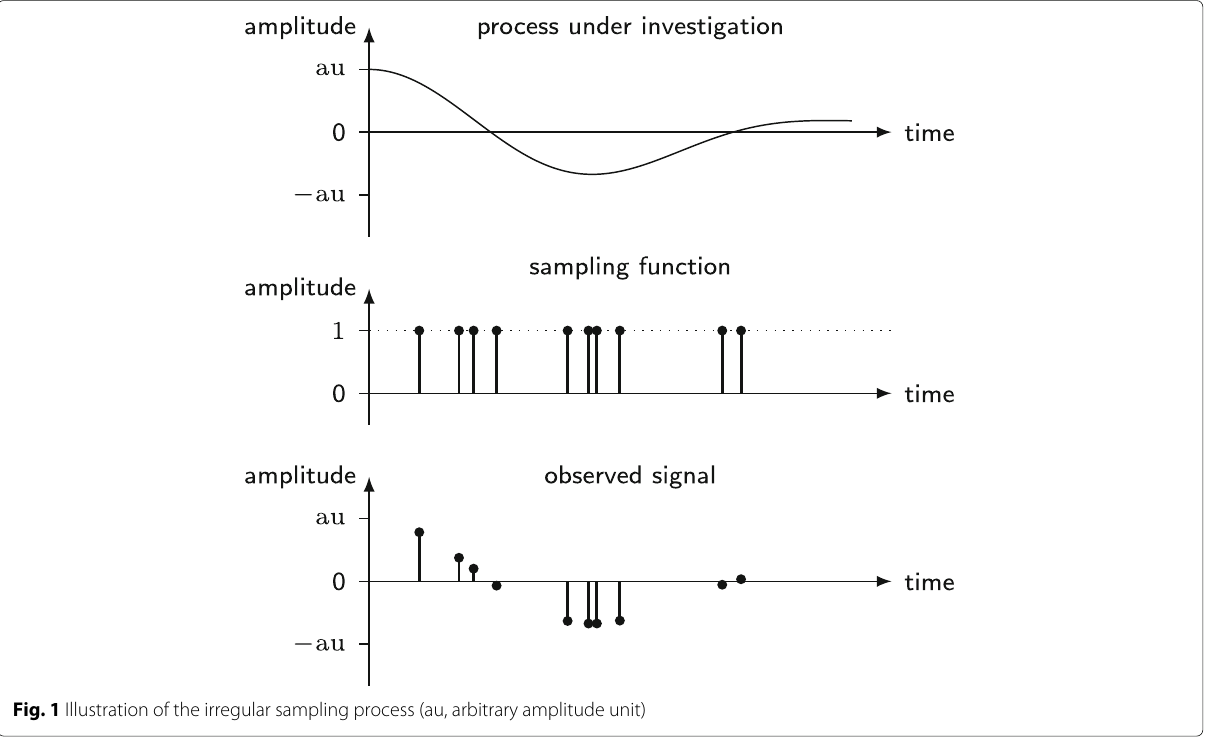
Fig. 1 Illustration of the irregular sampling process (au, arbitrary amplitude unit)